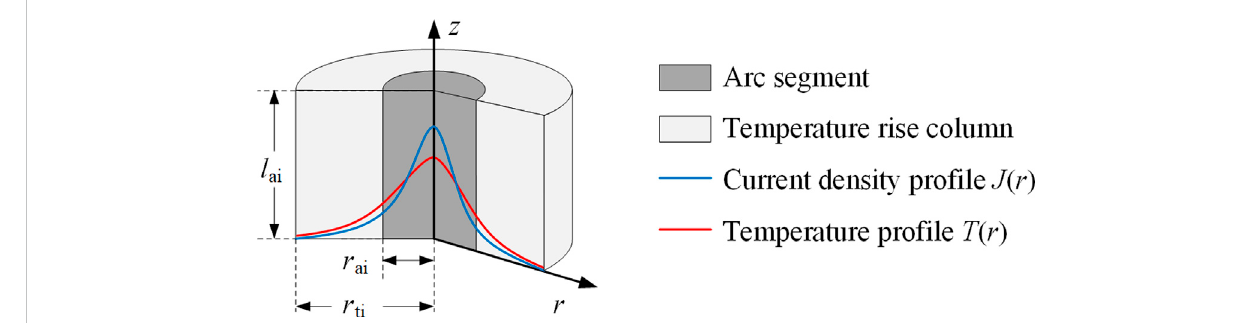
FIGURE 4 Zoning in the ionized air region.